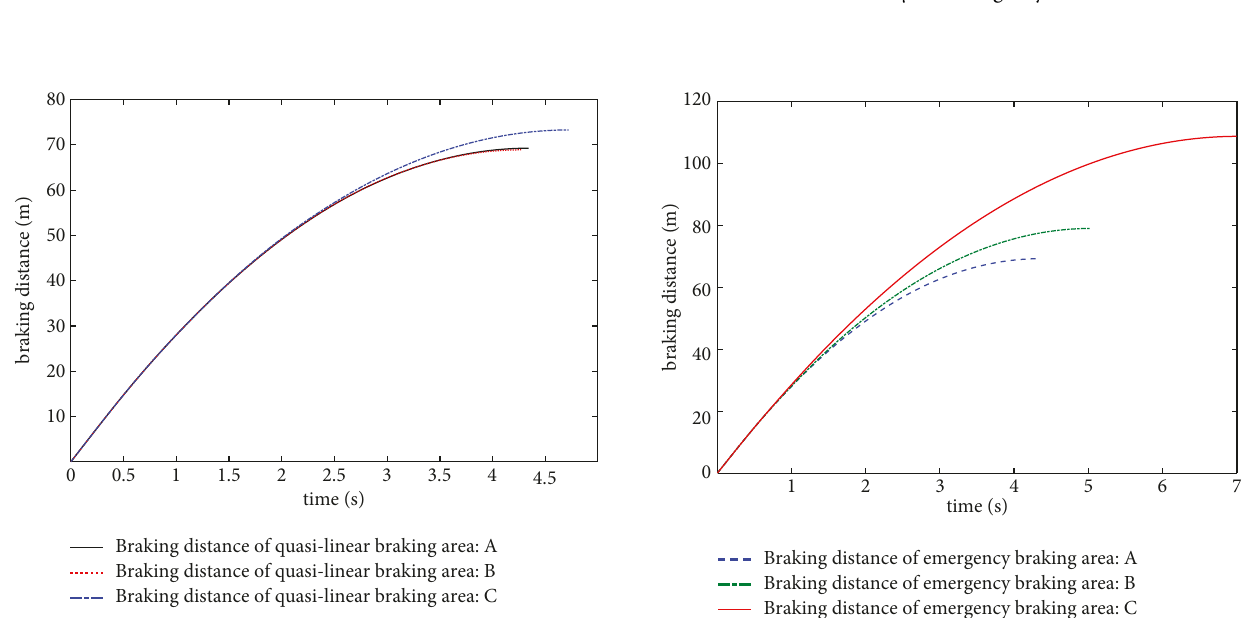
Figure 4: μ in quasilinear area.